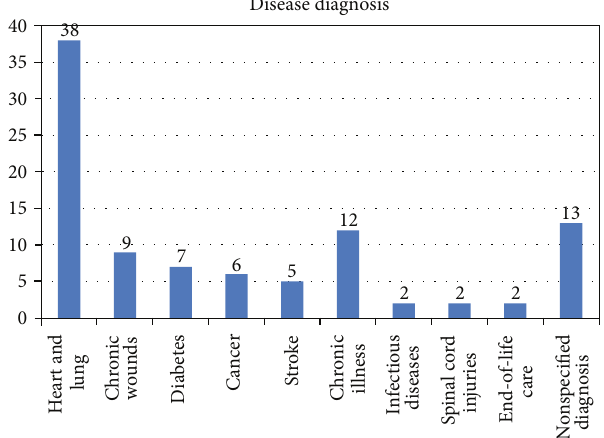
Figure 3: Number of studies per disease diagnosis.